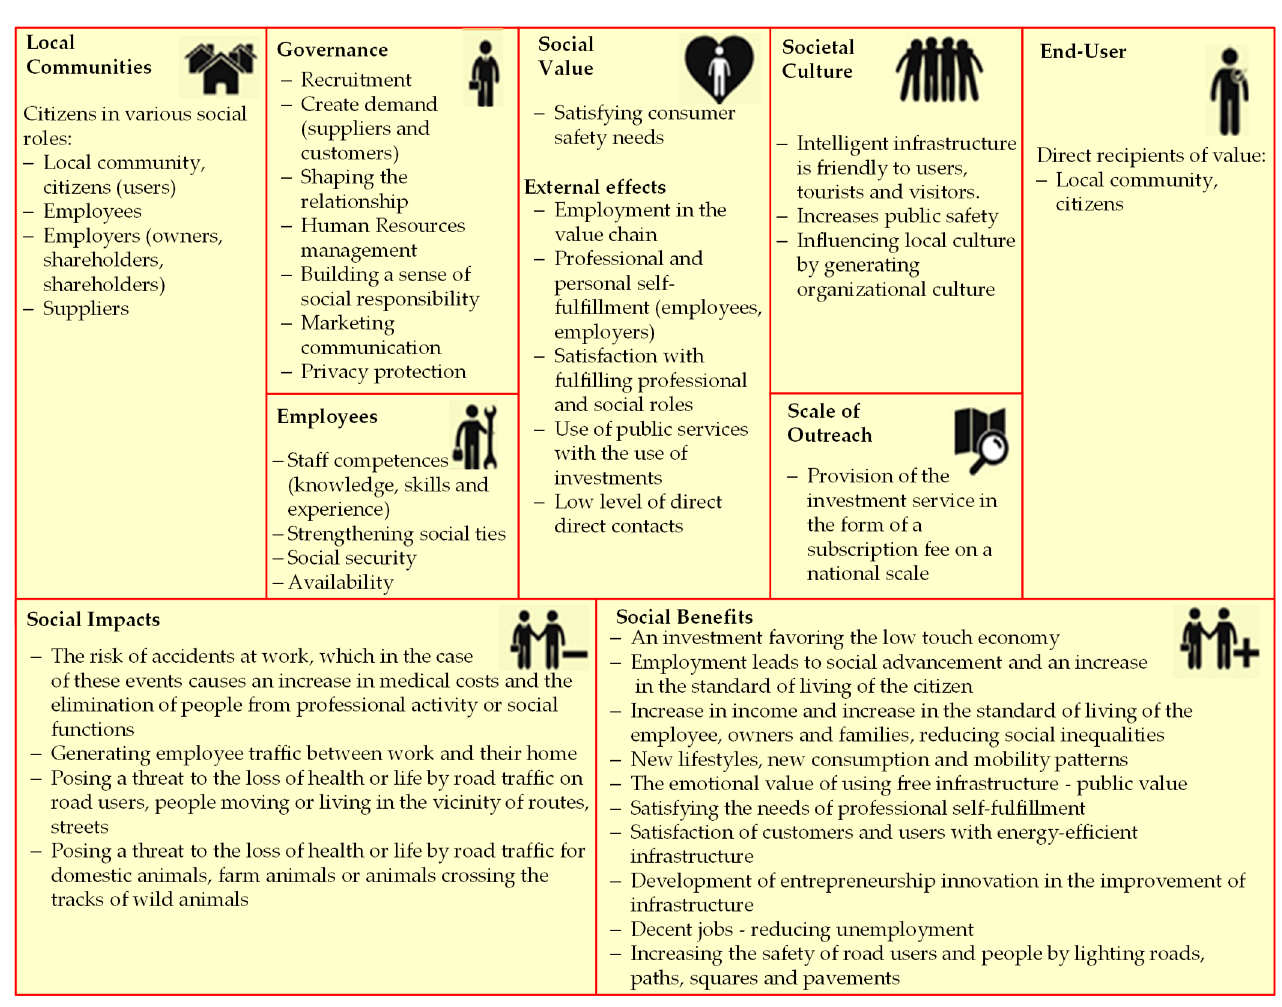
Figure 10. Social layer for sustainable development. Source: Own study based on the source [59].